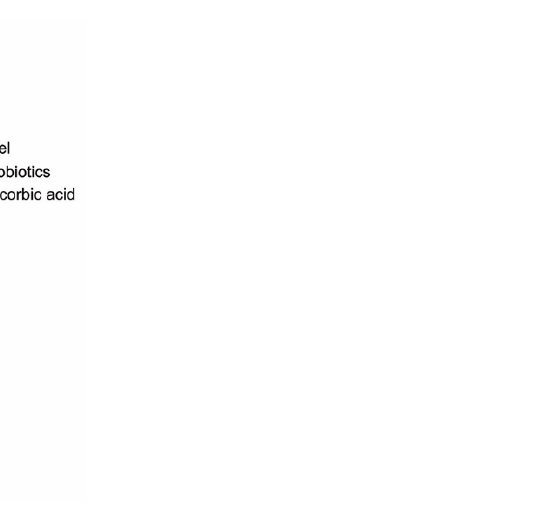
Figure 5. Effect of B. animalis MSMC83 treatment on composition of gut microbiota. Shannon index ( A ), Venn diagram representation of the number of OTUs ( B ), relative abundance of gut microbiota at the phylum level ( C ), heatmap of the gut microbiota at the genus level ( D ), and relative abundance of gut microbiota at the family level ( E ). All data are indicated as mean ± SD of 5 mice per group. ● , ■ , ▲ , ◆ as individually in each group. # p < 0.05, ## p < 0.01 as compared with the control group. * p < 0.05, *** p < 0.001, as compared with the D ‐ gal model group.